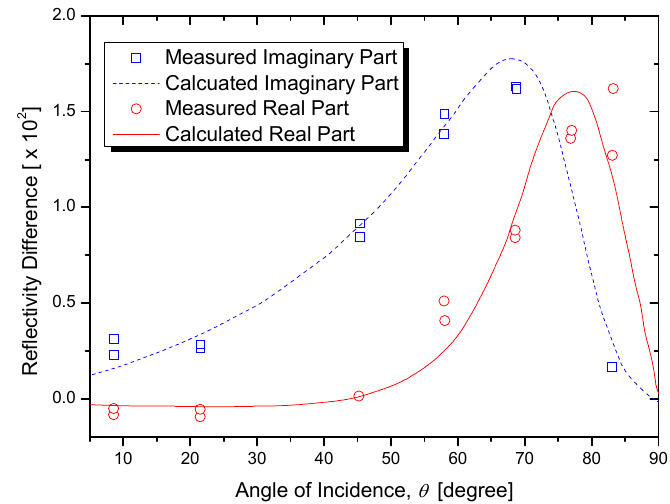
Figure 6. Reflectivity differences in response to TbDyFe film of 0.5 μ m thickness on Si substrate versus the incidence angle. The results are calculated using Equation (2).